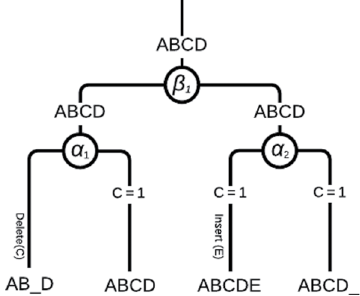
Figure 4: Simulation of gene investigation step between two genomes So all matching genes are directly assigned to the ancestor. For non-matching genes, the process consists of the selection of a third genome, among the cousins according to the provided tree. The selected cousin is the closest one to the two considered genomes, according to the chosen distance. It is then compared to the two sister species for each non-matching gene, if the cousin agrees with one sister, then the considered gene is added to the